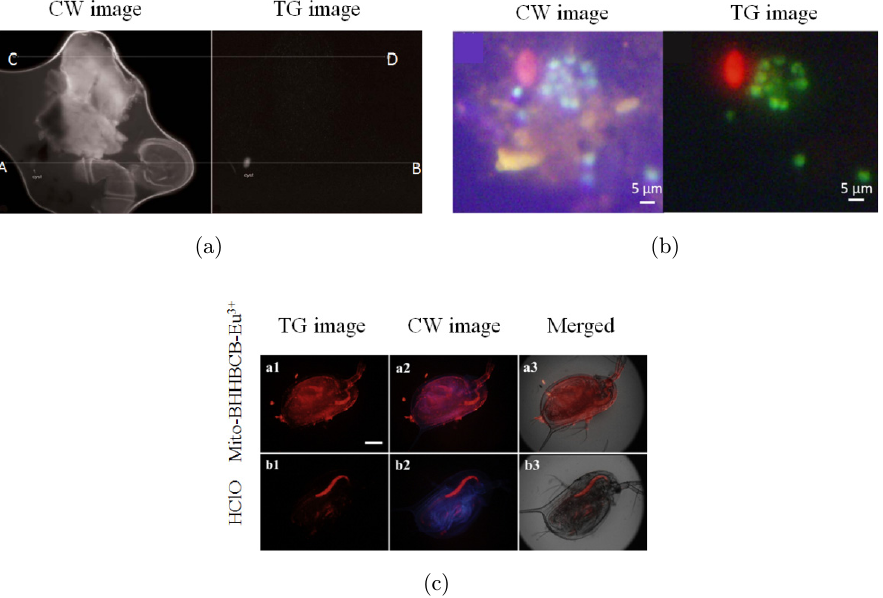
Fig. 10. (a) CW and TG images of Giardia cyst labeled with a BHHST (shown on lines A and B) and AF (shown on lines C and D). (b) CW and TG images of Giardia lamblia cysts labeled with a red europium probe and Cryptosporidium parvum oocysts labeled with a green terbium probe. (c) TG luminescence images of Daphnia magna loaded with Mito-BHHBCB-Eu 3 þ for 30 min (top, as control experiment), followed by incubation with HClO for 20 min (bottom) (1: TG image; 2: CW image; 3: merged image of bright ¯eld and TG images). Scale bar: 200 (cid:3) m. Reprinted with permission from Refs. 24, 71 and